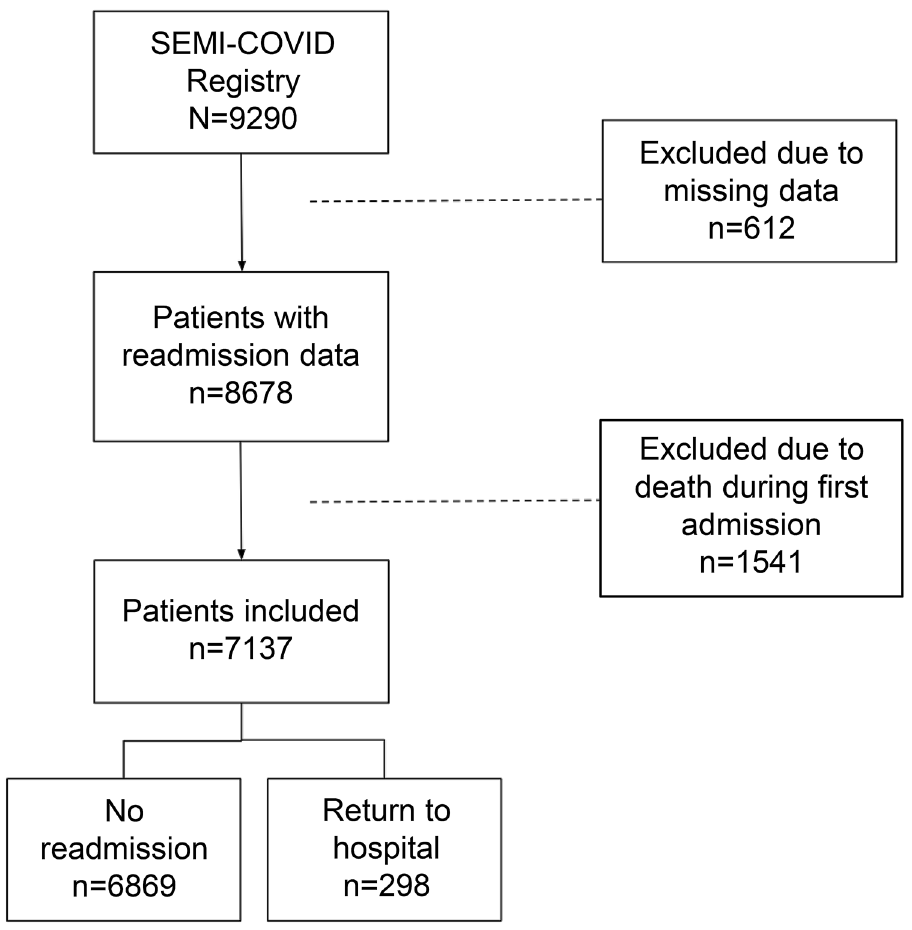
Figure 1. Flow chart of inclusion of patients with COVID-19 according to hospital